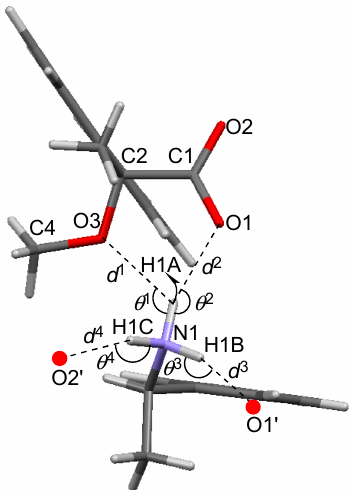
Figure 6. Geometrical parameters of methoxy-group-assisted salt bridges and other salt bridges in salts 6 – 9 .